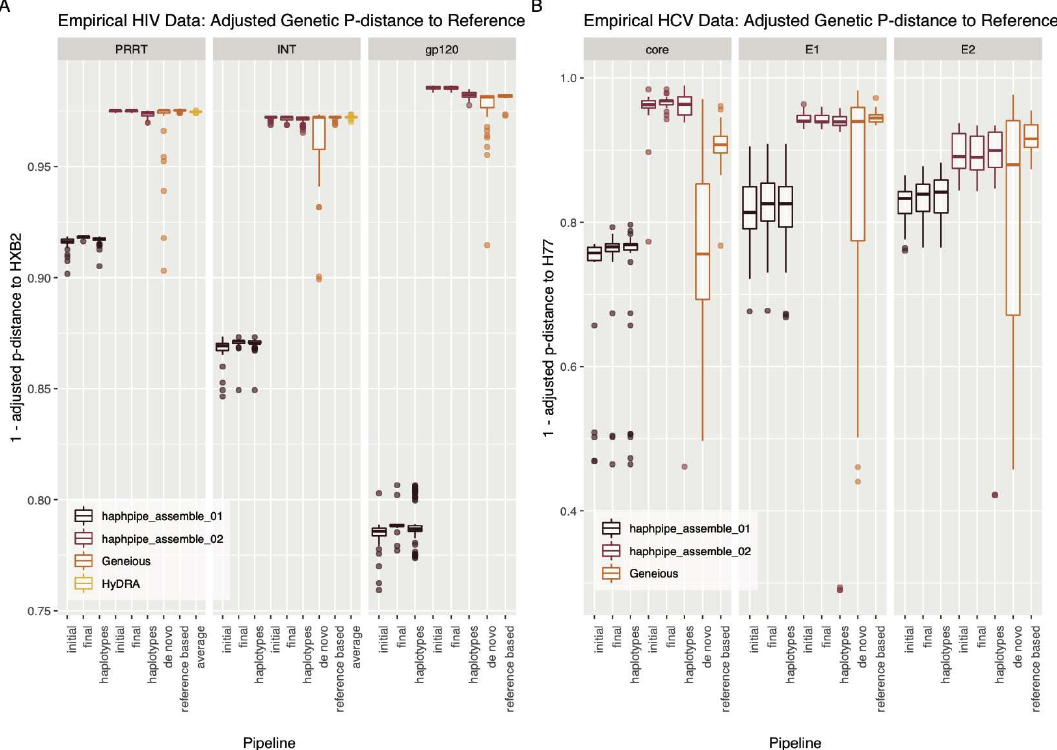
Figure 5. Adjusted genetic p-distance (displayed as a difference from 1) between consensus sequence and HXB2, the reference sequence for HIV, for all pipelines for the empirical ( A ) HIV dataset and ( B ) HCV dataset. Ambiguous nucleotides were accounted for by giving fractional weight in alignment. A value closer to 1.00 indicates that the consensus sequence is more genetically similar to the reference sequence. The y-axes are different for each HIV and HCV, with HCV showing greater variance between samples. The x -axis order from left to right for an individual panel: adjusted genetic p-distance between the reference sequence and (i) the initial assembled sequence, (ii) the final assemble sequence and (iii) the reconstructed haplotypes for haphpipe_assemble_01 pipeline (de novo assembly); (iv) the initial assembled sequence, (v) the final assemble sequence, and (vi) the reconstructed haplotypes for haphpipe_assemble_02 pipeline (reference-based assembly); the final consensus sequence for the Geneious (vii) de novo workflow and (vi) reference-based workflow; and finally, the (viii) average between the final two sequences (one for each read file) for HyDRA. The three amplicons are shown for both empirical datasets (HIV: PRRT , int , gp120 and HCV: core , E1 , E2 ). There are no results for HyDRA in the gp120 gene for HIV or for any HCV genes because HyDRA only analyzes the pol gene region of HIV. Table 4. Comparison of the e ff ect of consensus generation on estimated genetic diversity across the empirical HIV dataset. PRRT int gp120 Pipeline